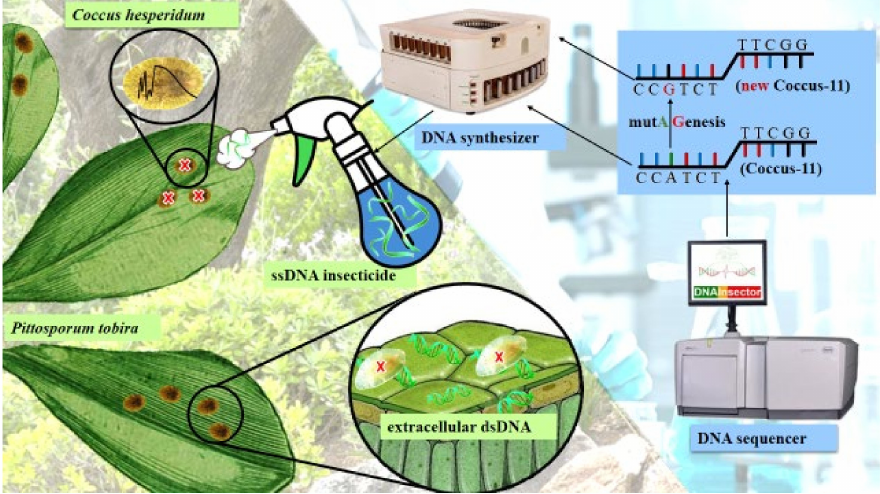
Figure 3. The concept of green DNA insecticides for